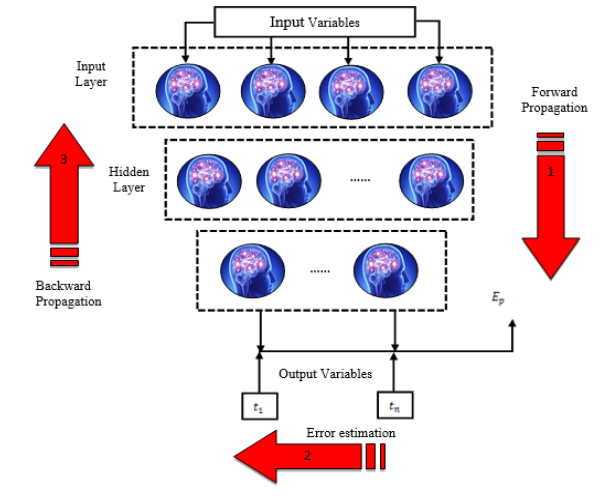
Figure 5: Typical structure of a BP network (Lai et al., 2016)